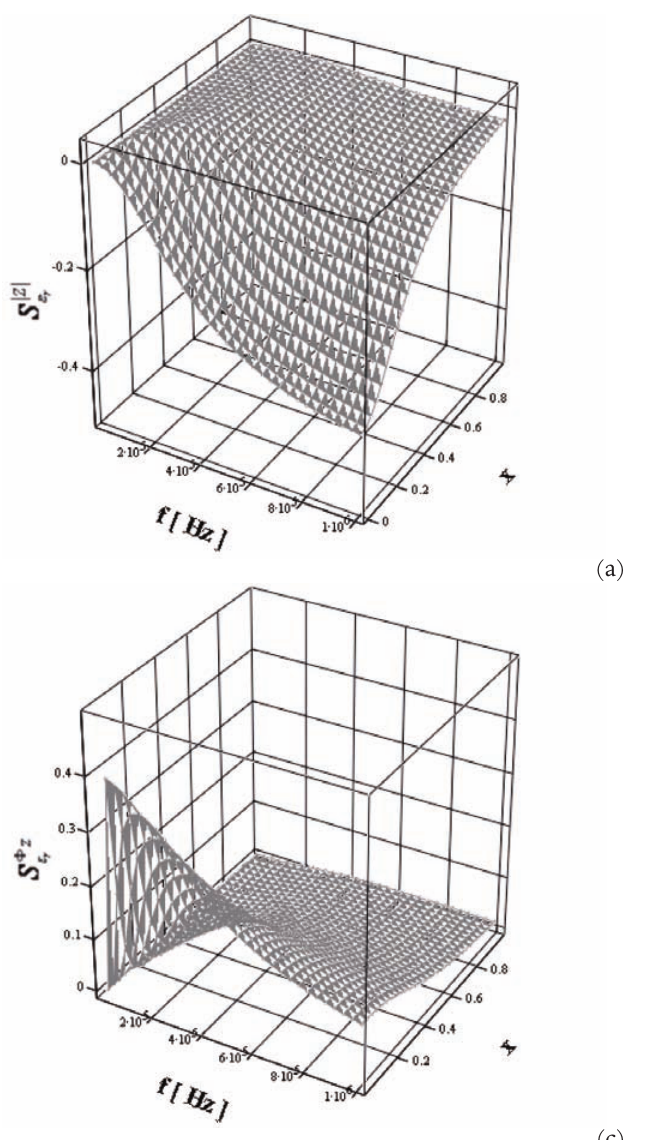
, relative to the dielectric permittivity f , plotted: Z r under the same operative r